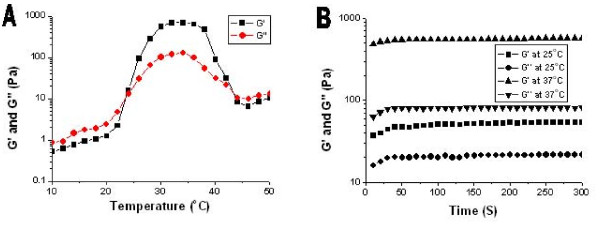
A: Rheology analysis of PECE-hydrogel (25 wt%) as a function of temperature. B: Time dependence of storage modulus G' and loss modulus G'' at different temperature.